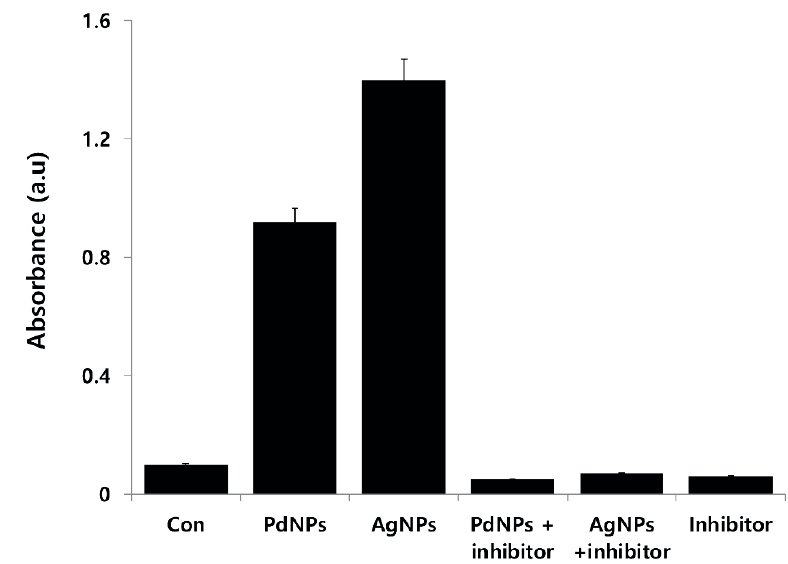
Figure 12. Effect of palladium nanoparticles (PdNPs) on caspase-3 activity in human ovarian cancer cells. Ovarian cancer cells were treated with 10 µ g/mL of PdNPs with or without caspase-3 inhibitor (Ac-DEVD-CHO) for 24 h. Concentration of p -nitroanilide released from substrate was calculated from absorbance at 405 nm. Results are mean ± standard deviation (SD) of three separate experiments.